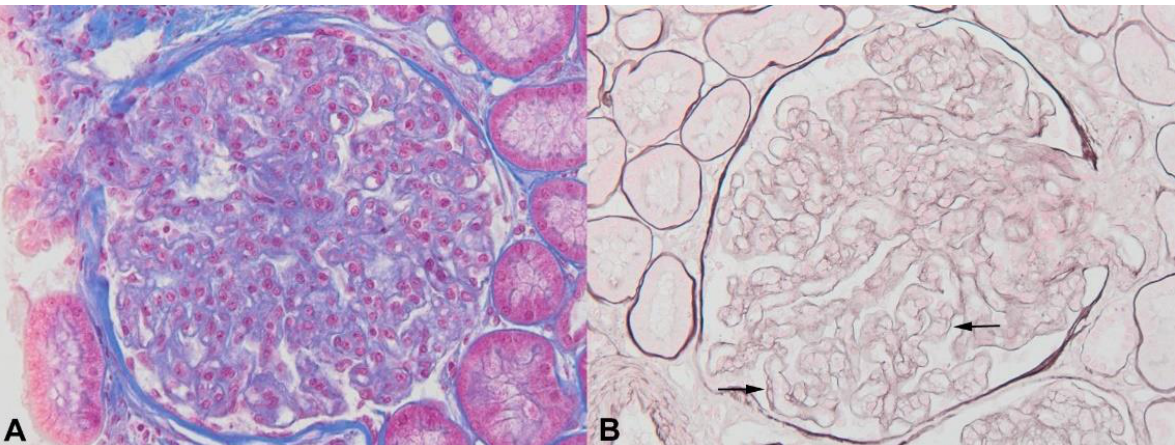
Figure 6. Thrombotic microangiopathy associated with POEMS syndrome. Glomerular enlargement with mesangium loosening, endothelial cell swelling (( A ), Masson trichrome staining ×400) and double contours (( B ), Jones methenamine silver, ×400, arrows).